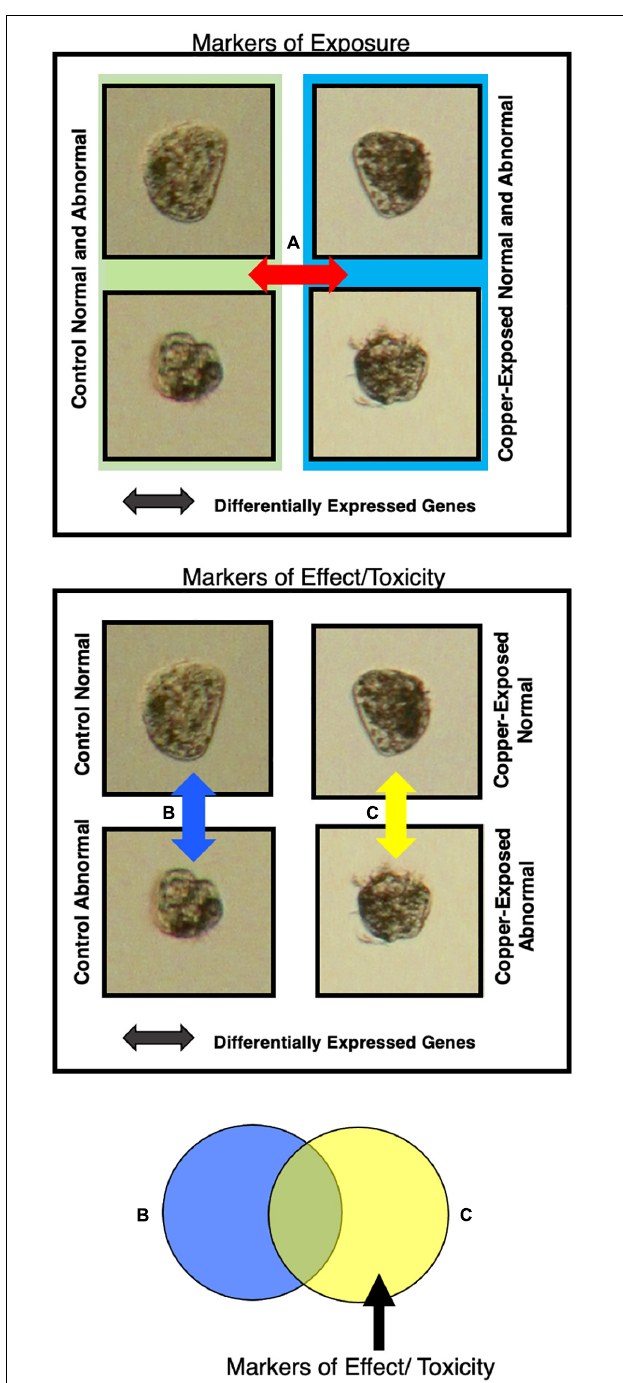
FIGURE 2 | Markers of effect and markers of exposure were detected by isolating gene sets that were differentially expressed between animals exposed to different copper concentrations and that exhibited different morphologies. Markers of exposure were considered genes that were differentially expressed between all animals (normal and abnormal) at the control copper concentration and all animals at each copper concentration (A) . Markers of effect were considered genes that were differentially expressed between normal and abnormal animals in copper-treated larval samples, but not in control samples (B,C)